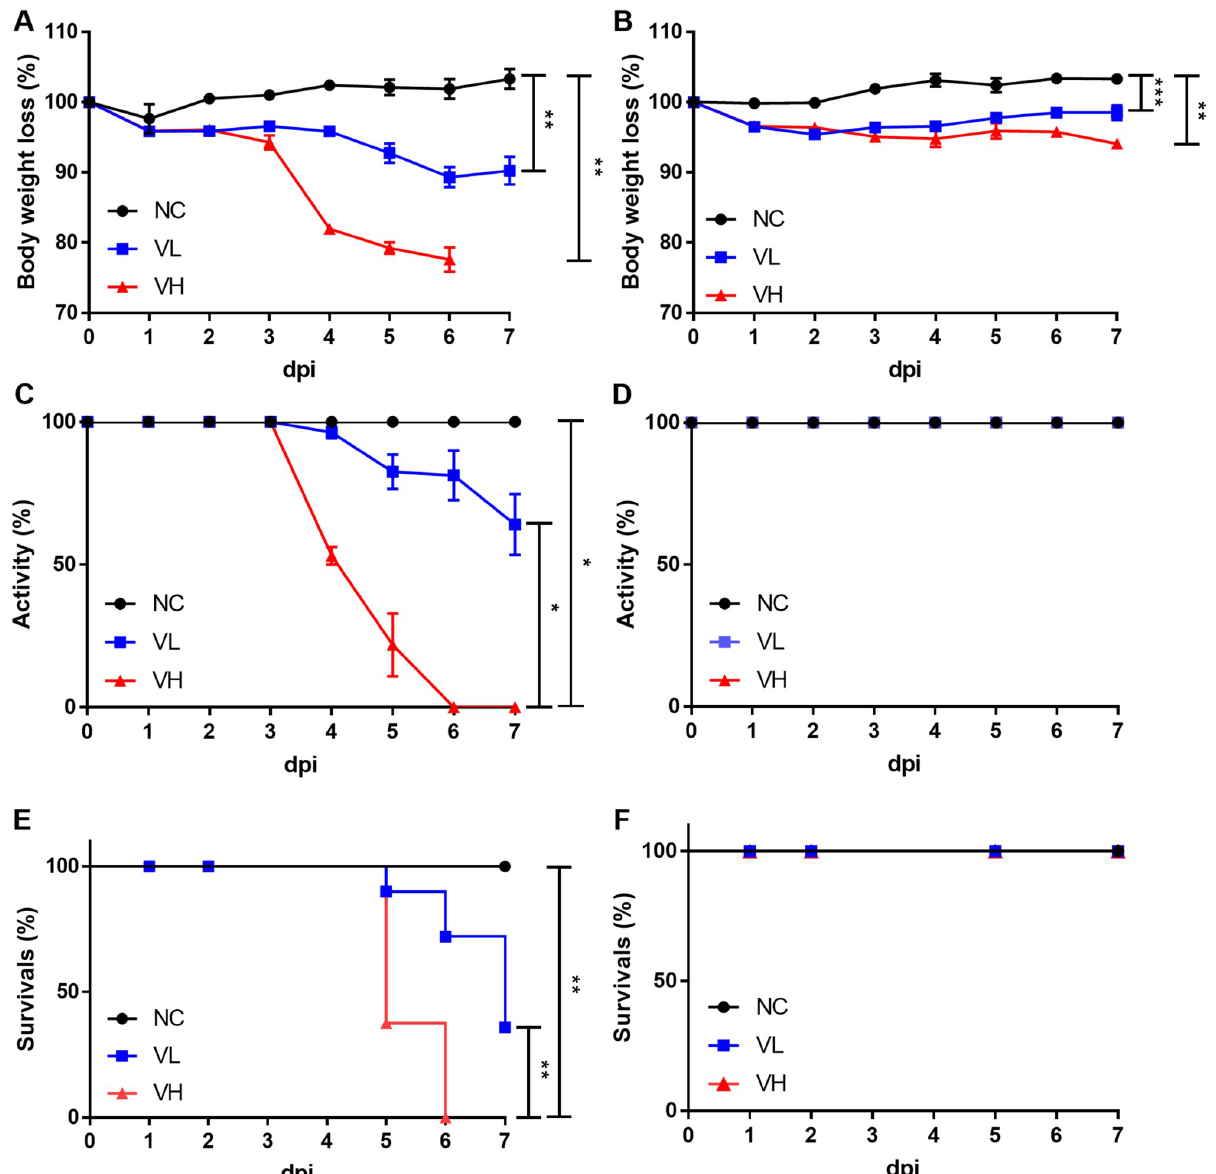
Fig 2. Differences in morbidity and mortality due to SARS-CoV-2 infection in K18-hACE2 (n = 40) and CAG-hACE2 (n = 33) lineages. (A) shows weight loss of K18-hACE2; (B) shows weight loss of CAG-hACE2; (C) shows activity score of K18-hACE2; (D) shows activity score of CAG-hACE2. (E) shows survival rate of K18-hACE2; (F) shows survival rate of CAG-hACE2. Data is represented as mean ± SE at indicated day post-infection (dpi). � P < 0.05; �� P < 0.01; ��� P < 0.001 as assessed using unpaired two-tailed t-test and log-rank test. maximum titers at 5 dpi and 2 dpi, respectively, with median values of 1.1 x 10 7 and 8.6 x 10 5 TCID SARS-CoV-2/lung. Viral titer gradually decreased after reaching the maxima. During 50 the entire study, in VL groups of both lineages, the titers of SARS-CoV-2 were approximately 10 4 TCID SARS-CoV-2/lung. However, in the VH group, the viral titer of CAG-hACE2 50 appeared to be 10 5 –10 6 TCID SARS-CoV-2/lung, whereas K18-hACE2 appeared to be rela- 50 tively high at 10 6 –10 7 TCID SARS-CoV-2/lung. Comparing the VL and VH groups in each 50 lineage, a significant difference was observed in the virus titer of each group at 2 and 7 dpi for